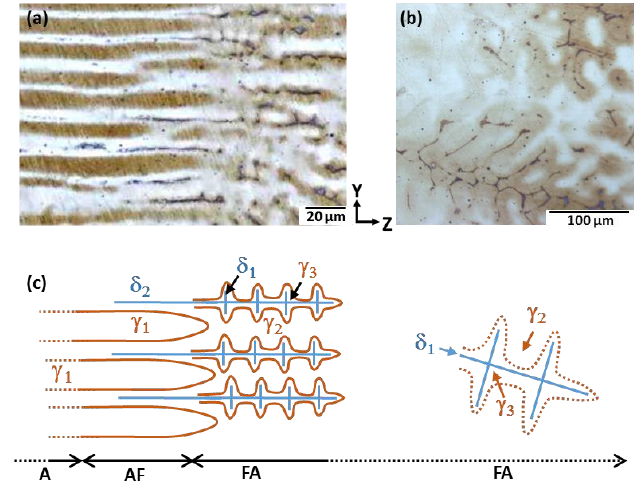
Figure 4. ( a , b ) Optical micrographs of the weld metal after Lichtenegger and Bloesch etching: austenite is colored in dark/light brown relative to its composition, and ferrite in black. ( a ) Microstructure in the first 150 µm close to the fusion line; ( b ) Microstructure at 4 mm from fusion line; ( c ) Schematic of the transitions in the solidification mode: cellular A mode (γ 1 ), cellular AF mode (γ 1 , δ) and dendritic FA mode (δ 1 , γ 2 , γ 2 ).